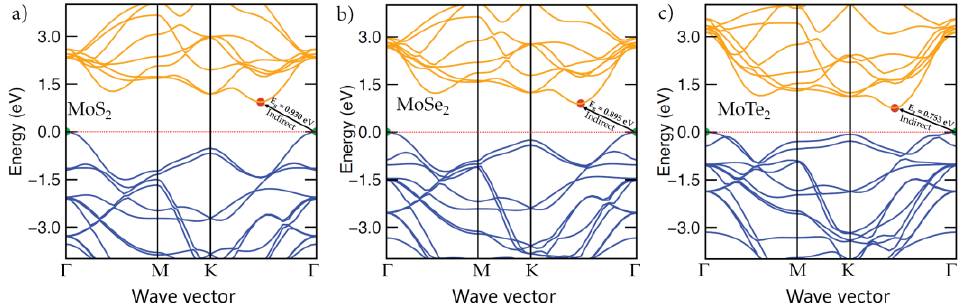
Table 4 . Comparison computed bandgaps and HOMO – LUMO gap (eV) with experiment for MoCh 2 (Ch = S, Se, Te) systems .